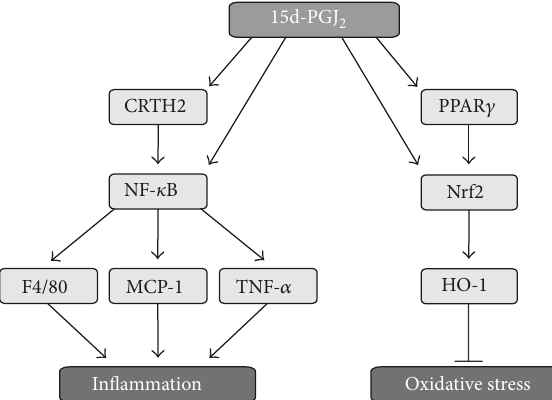
Figure 5: Potential mechanisms involved in the antioxidant and proin fl ammatory actions of 15d-PGJ . Ureteral obstruction 2 induces oxidative stress and in fl ammation. We observed that 15d- PGJ prevents the increase in oxidative stress, probably through 2 activation of the transcription factor Nrf2 and its downstream target HO-1. PPAR γ has previously been shown to activate Nrf2 and might therefore be involved in oxidative protection. 15d-PGJ 2 was shown to exacerbate in fl ammation through the activation of NF- κ B and its downstream targets MCP-1 and TNF- α as well as via macrophage in fi ltration (F4/80). CRTH2 has been shown to activate the in fl ammatory response and might be involved in the 15d-PGJ -mediated activation of NF- κ 2